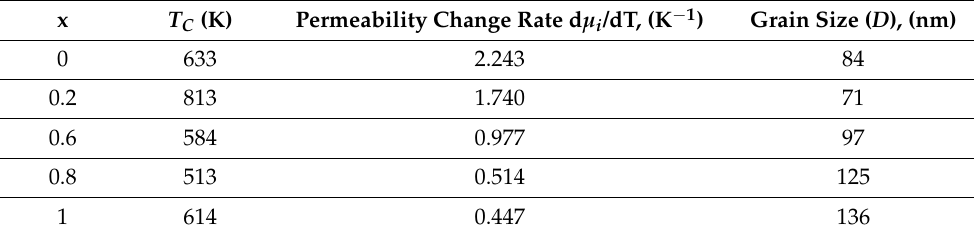
Table 7. The Curie temperature ( T C ) determined from the initial permeability data,